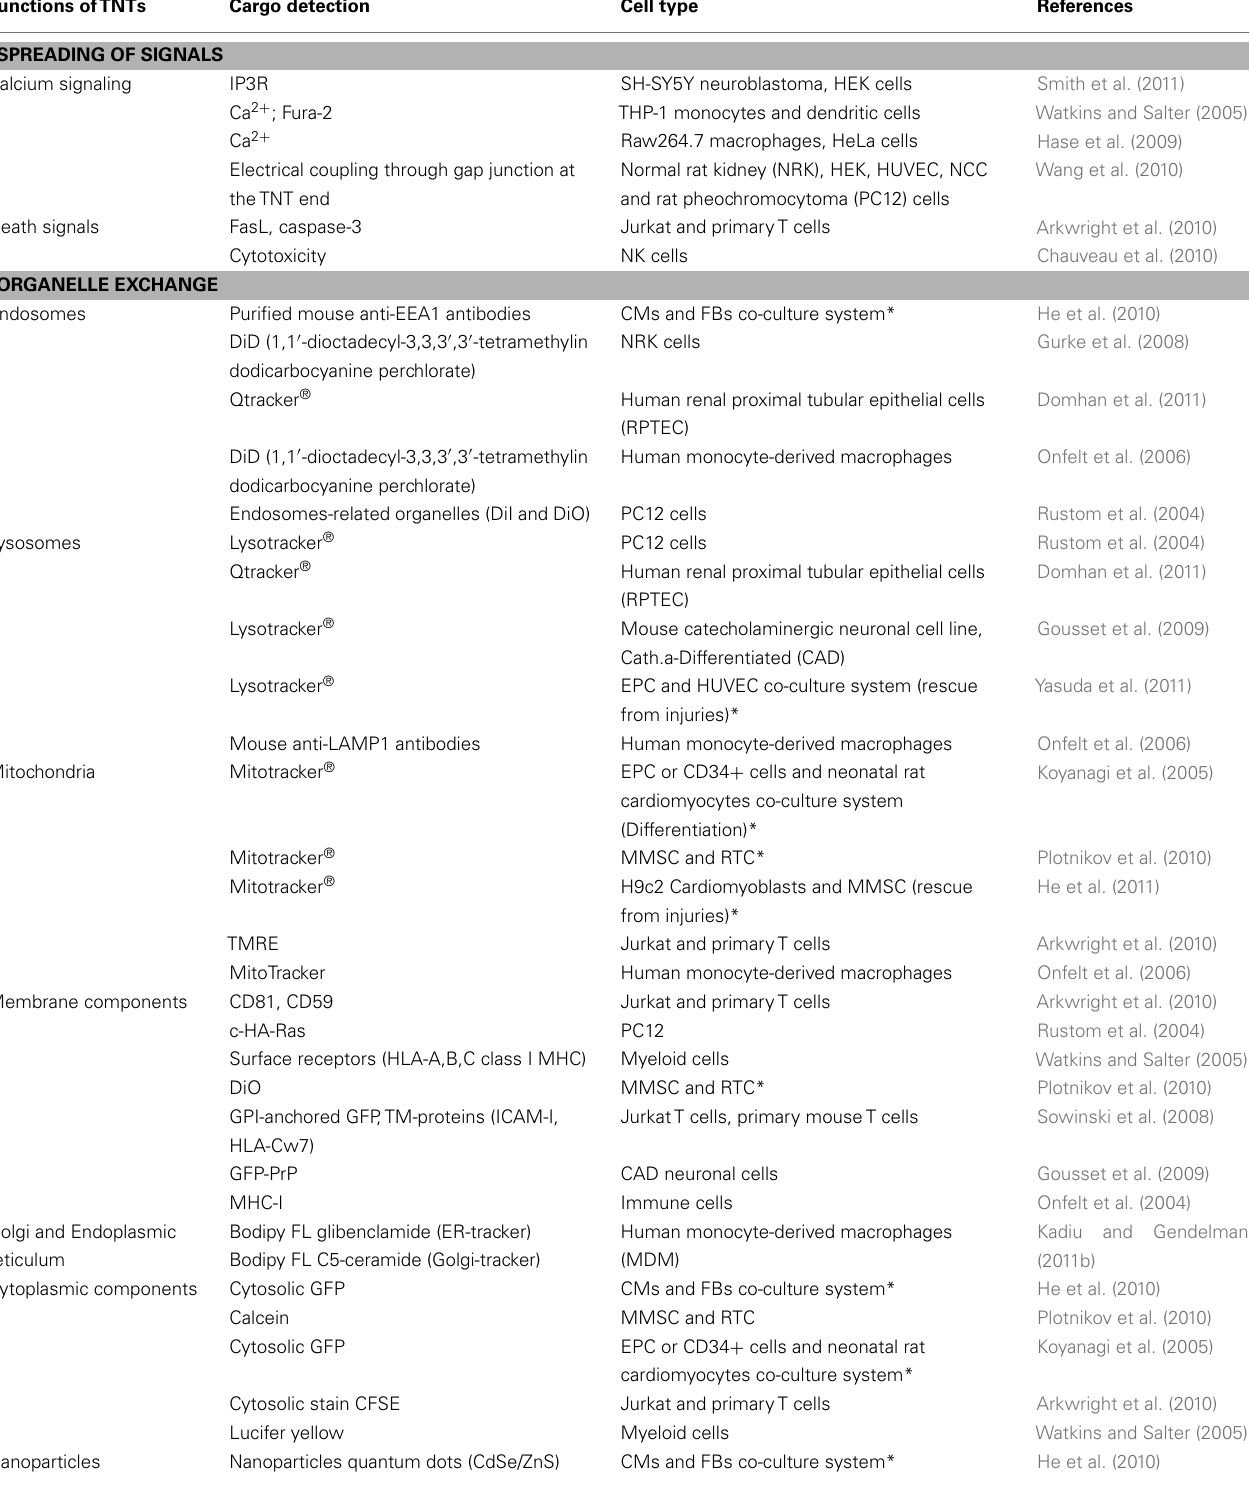
Table 1 | Overview of the different cargos found inTNT-like